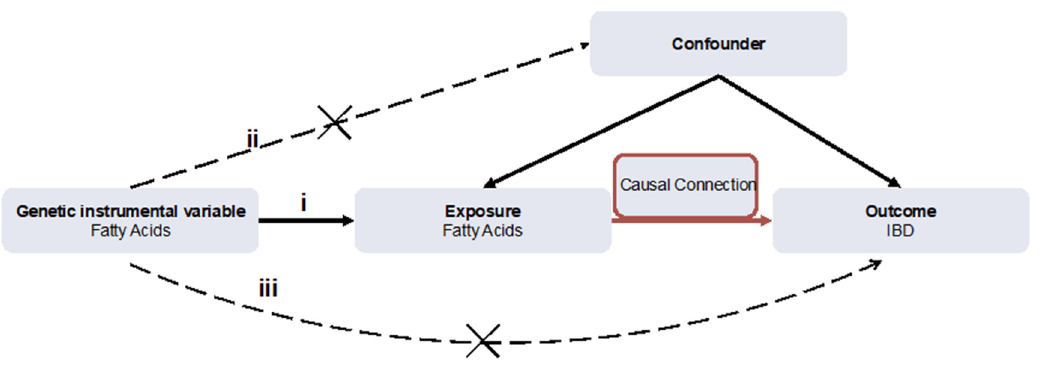
Figure 1. The flow diagram of the Mendelian randomization (MR) study. (i) The genetic instrumental variables (IVs) are strongly associated with fatty acids (FAs); (ii) The genetic IVs do not affect the outcome through the confounders; (iii) The genetic IVs do not affect inflammatory bowel disease (IBD) directly, but only via indirect exposure.